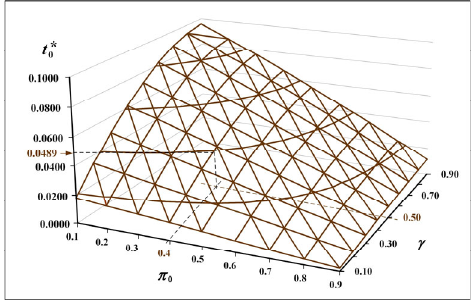
Fig. 16. t 0* ’s performance concerning the collective effects of π 0 and